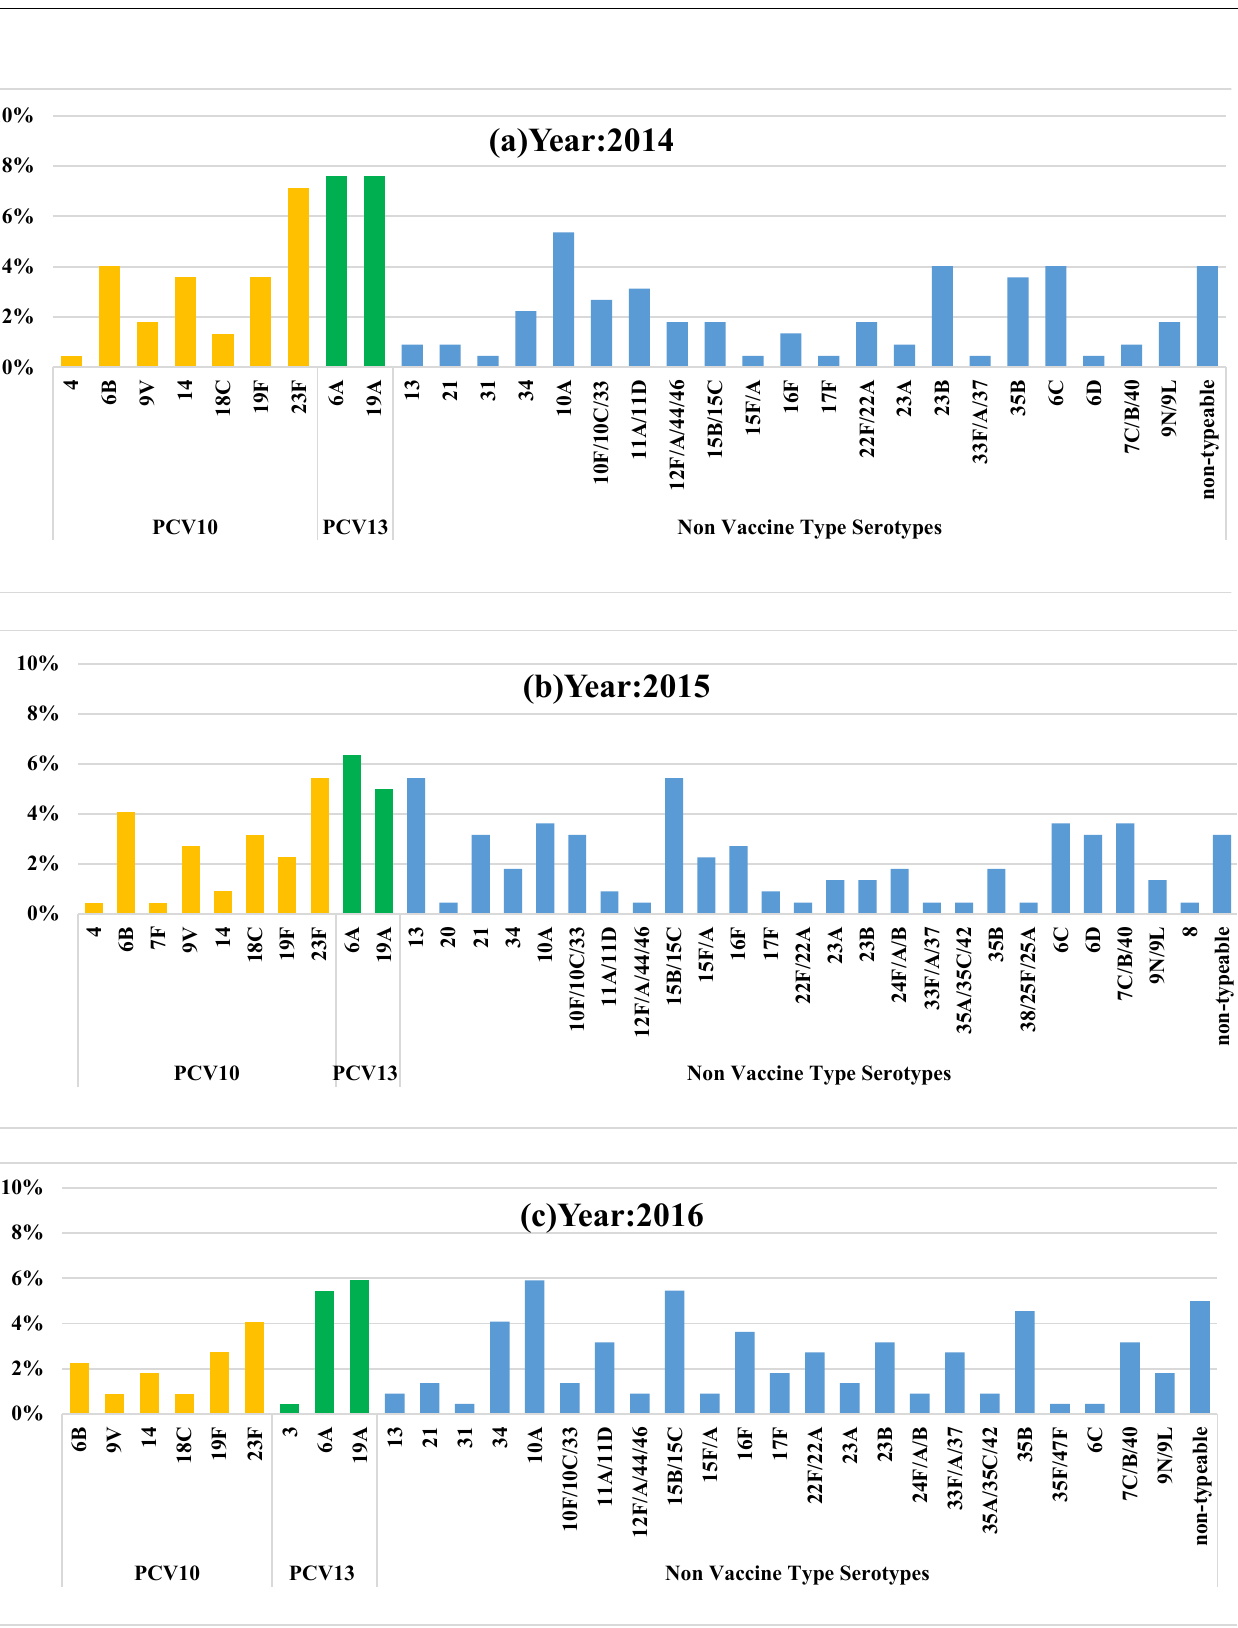
Figure 2. Prevalence of pneumococcal serotypes across three surveys ( a ) 2014, ( b ) 2015. and ( c ) 2016 in children 3–12 months old in Matiari, Pakistan.